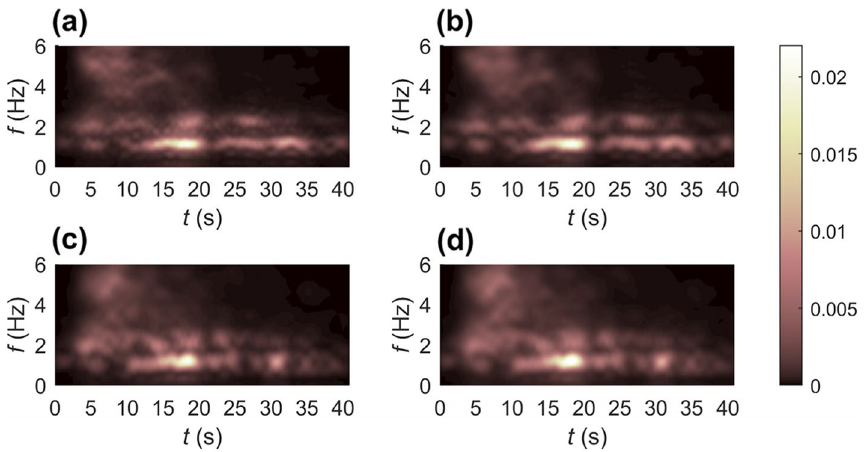
Fig. 13 EPSD of the simulated earthquake time histories at a site 1, b site 2, c site 5, and d site 6 of the Jiuzhou